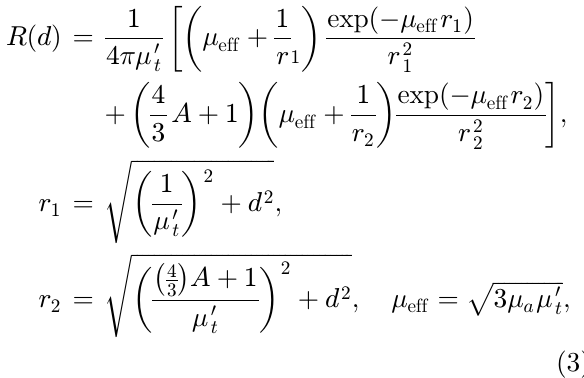
ffiffiffiffiffiffiffiffiffiffiffiffiffi